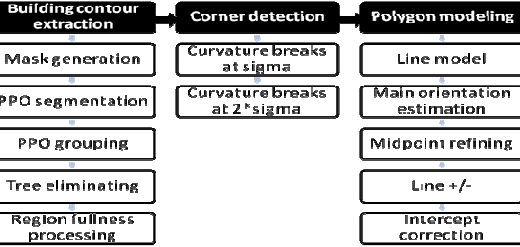
Figure 1 Block diagram of 2D building outline modelling method